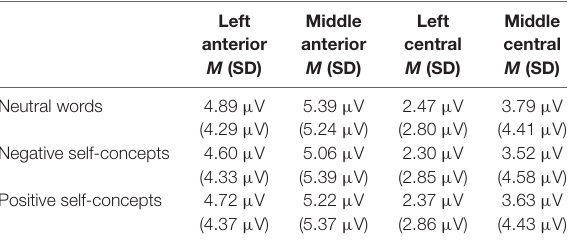
TABLE 1 | The average P150/N170 amplitudes and standard deviations for neutral words, negative self-concepts and positive self-concepts words over different